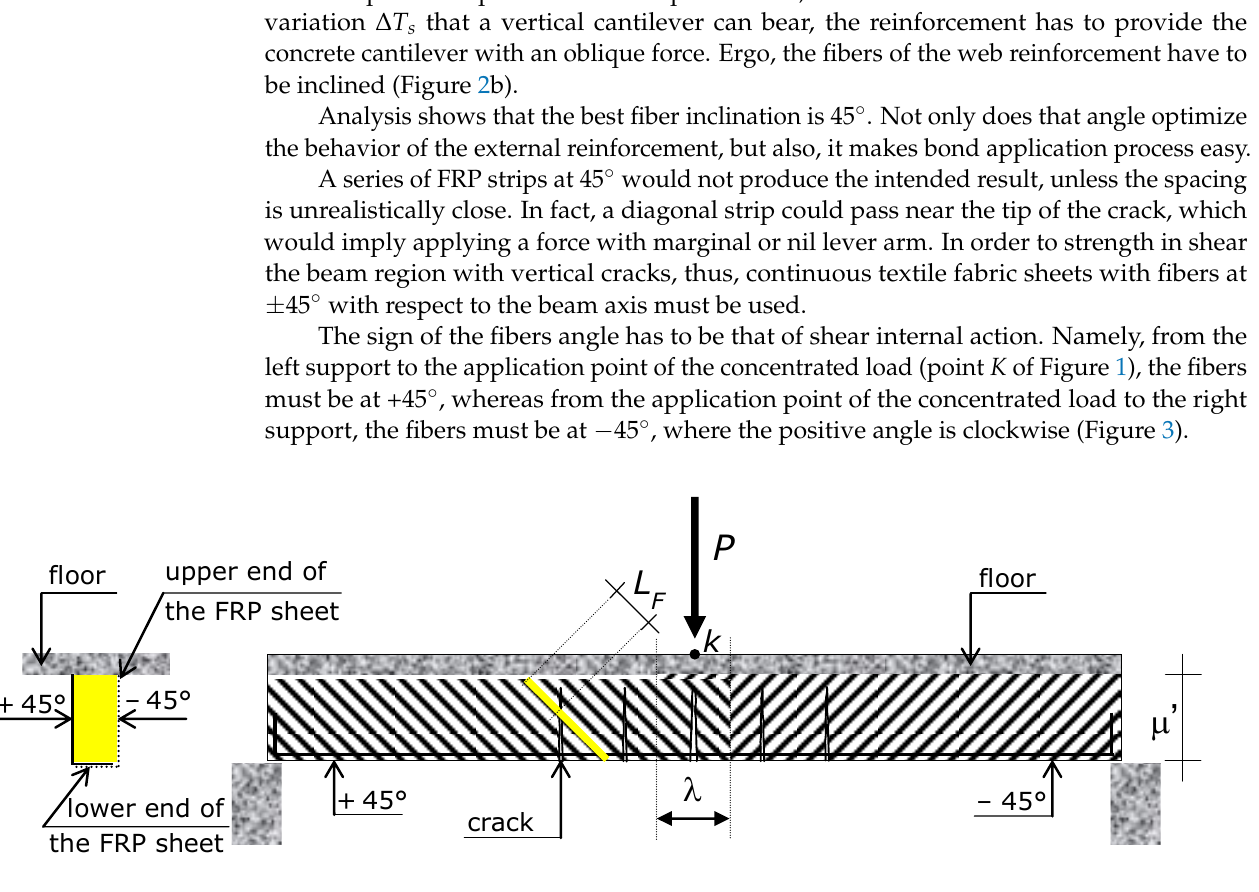
Figure 3. Externally bonded reinforcement that strengthens the RC beam subjected to a concentrated load: fabric sheets composed of unidirectional fibers at an angle of + 45° with the beam’s axis, where load: fabric sheets composed of unidirectional fibers at an angle of + 45 ◦ with the beam’s axis, where the shear force is positive, and at −45°, where the shear force is negative. the shear force is positive, and at − 45 ◦ , where the shear force is